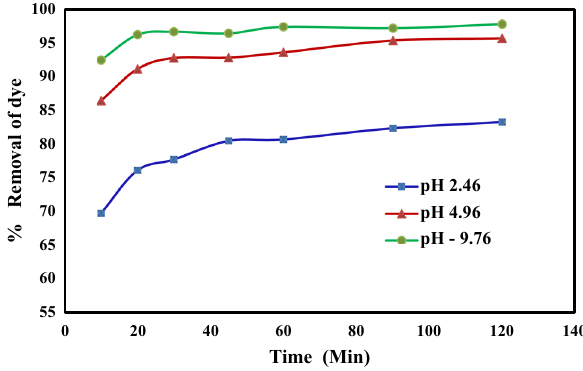
Fig. 8 Effect of temperature on removal of MG (NLP: 3 g/l, pH: 4.97,